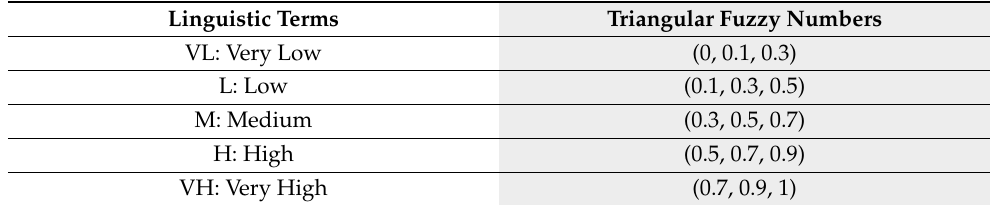
Table 10. Linguistic variables